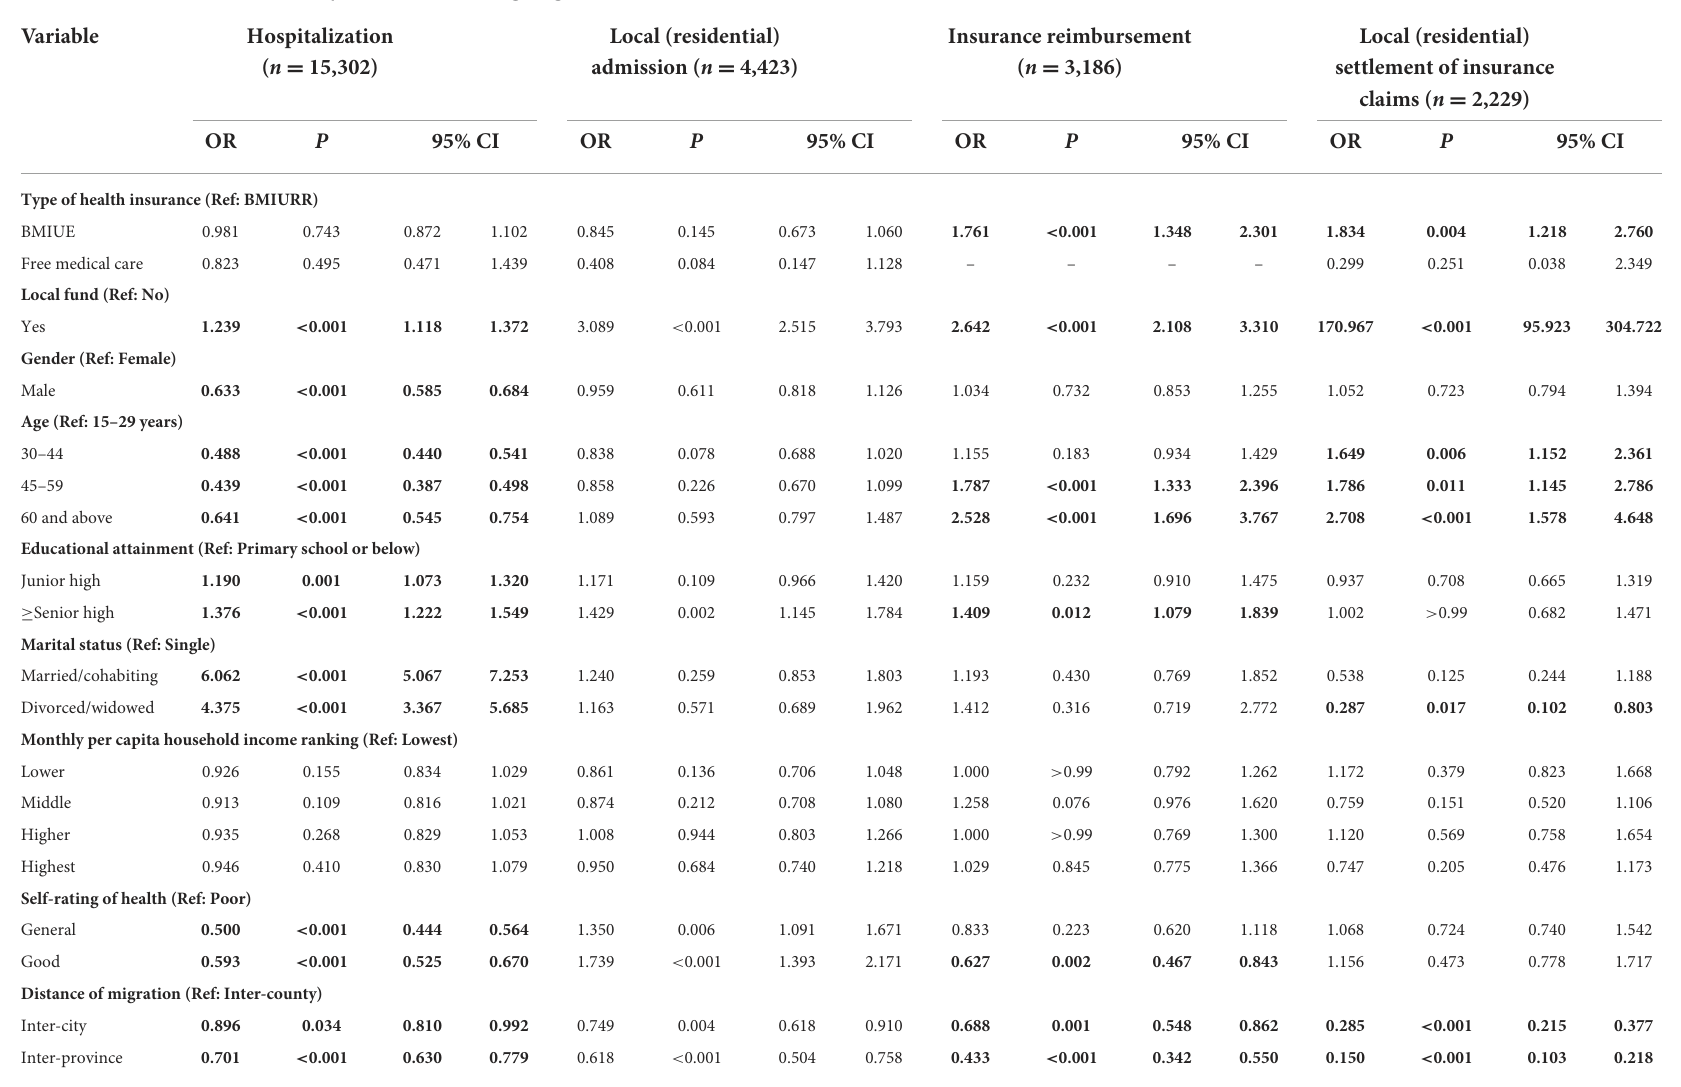
TABLE 4 Health insurance use for hospital care: results of logit regression models.